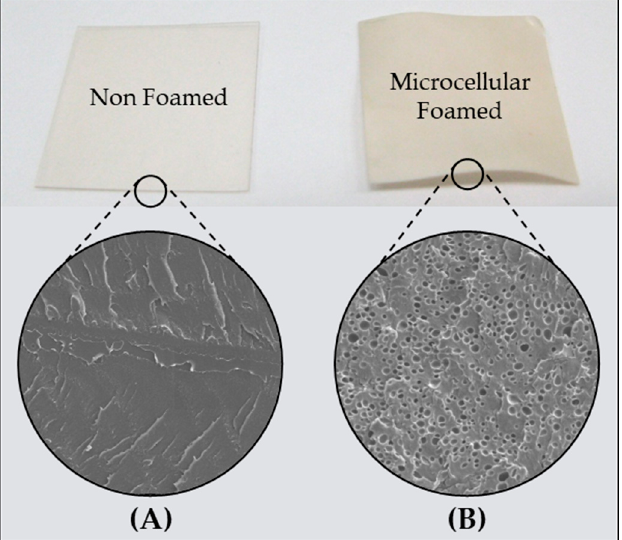
Figure 5. Comparison of appearance and cross section of ( A ) non-foamed and ( B ) microcellular foamed Nafion specimens.